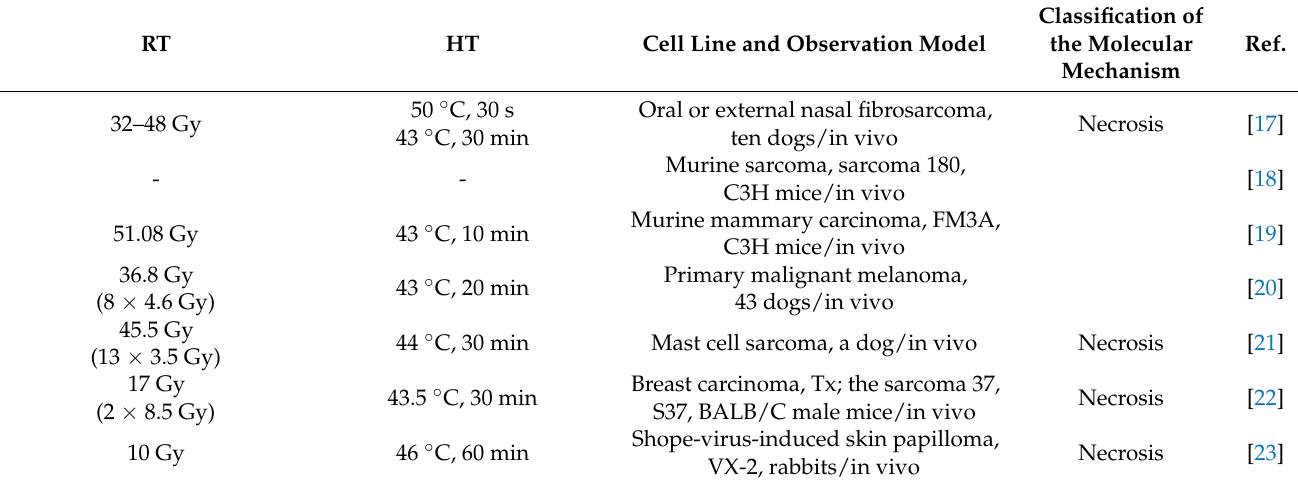
Table 1. Effect of RT + HT on tumor cells (unknown